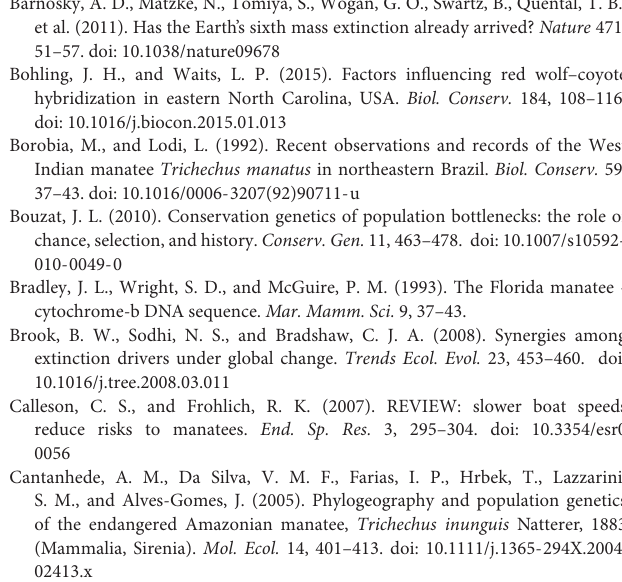
Supplementary Figure 1 | Results from S TRUCTURE and Structure Harvester Software for the substructure within the Amazonian grouping and including “Poque,” a suspected hybrid. Bar plot presents S TRUCTURE results as each individual as a line, assigned to inferred population clusters, K , designated by colors. “Poque” was included in the analysis and is indicated by an asterisk symbol ( ∗ ). Scatter plot presents Structure Harvest results with the mean estimate ln(P)D as open circles on the left y -axis; black lines through the open circles represent standard deviation among the individual iterations for each K . The gray dot-line plot visualizes the (cid:49) K values on the right y -axis. The value K on the x -axis indicates the number of clusters inferred. Supplementary Figure 2 | Control Region mtDNA complex haplotype network (epsilon = 1) for all study samples from Brazil (BR), Venezuela (VE)/Guyana (GY), Amazonian (AM), and manatees from captivity. Size of the circles represent sample size with sectors of circles indicating samples from different locations with shared haplotypes. Black tick marks indicate the number of mutations separating the various haplotypes. Black dots indicate potential haplotype missing from the